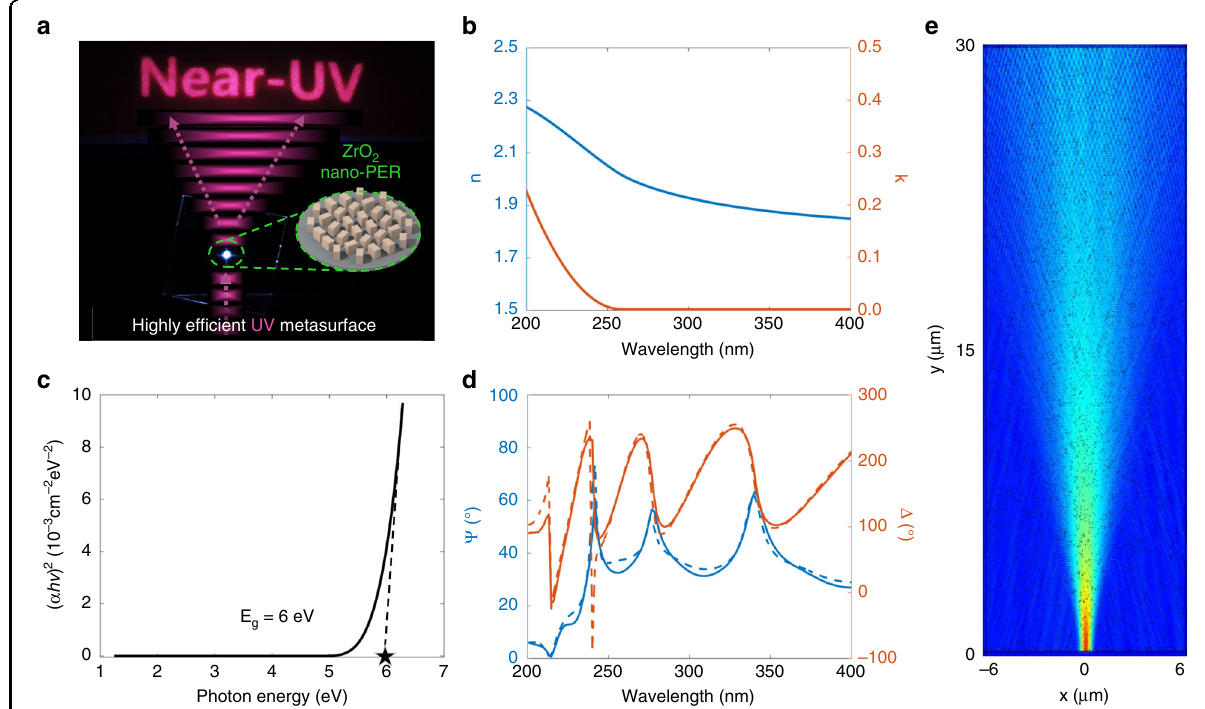
Fig. 1 Optical characterization of ZrO 2 nano-PER. a Schematic of the UV metasurface made up of ZrO 2 nano-PER. b Measured complex refractive index of ZrO 2 nano-PER fi lm. Blue line represents the refractive index ( n ) and the orange line represents the extinction coef fi cient ( k ). c Calculated optical band gap of ZrO 2 nano-PER fi lm. d Measured amplitude ratio and phase difference of ZrO 2 nano-PER fi lm using ellipsometry. (Solid line: measured data; dashed line: model data) e Simulated scattering effect of a Gaussian beam propagating in the nano-PER fi